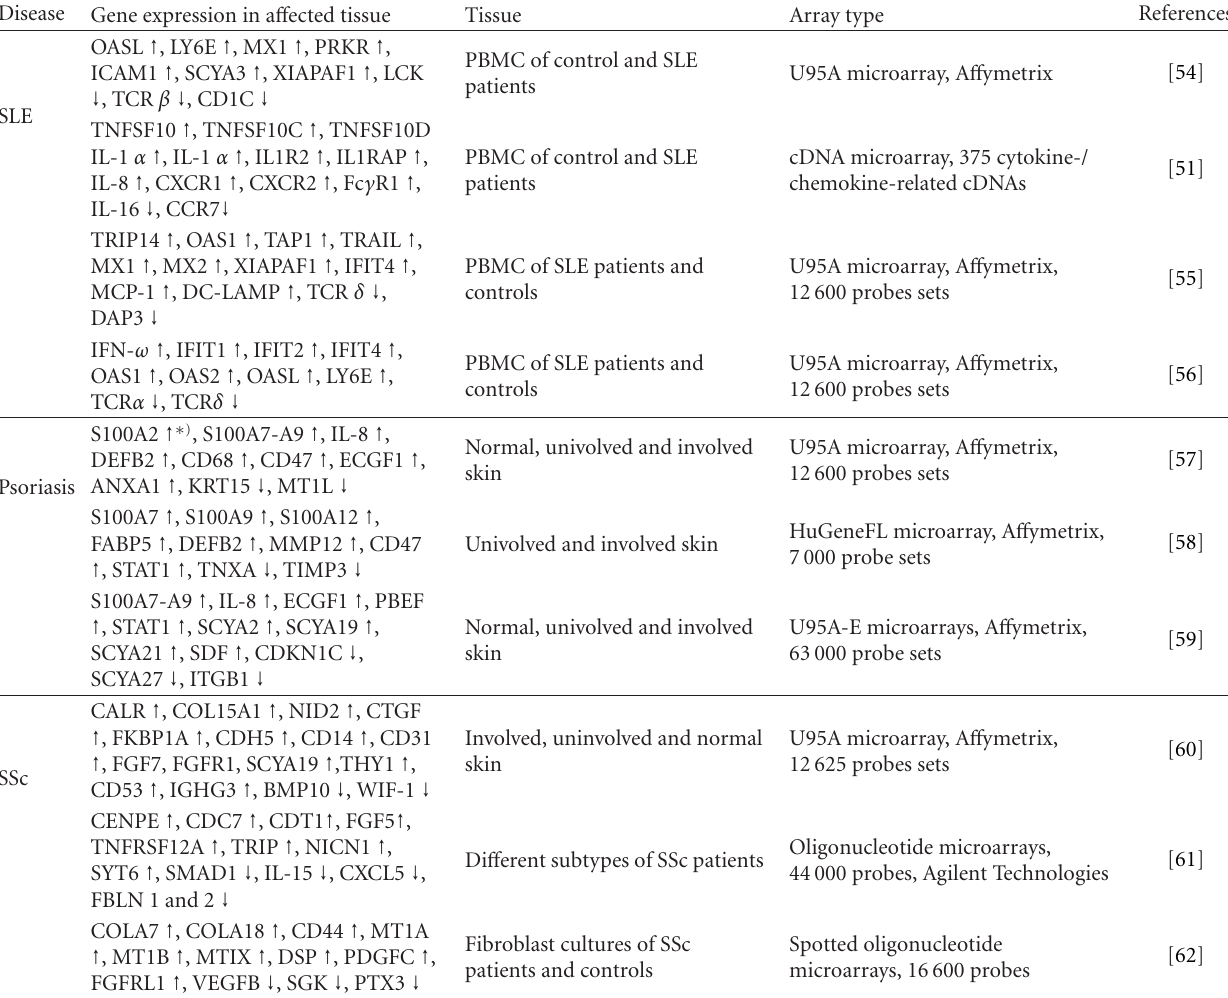
Table 2: DNA microarray studies on systemic lupus erythematosus (SLE), psoriasis, and systemic sclerosis (SSc).